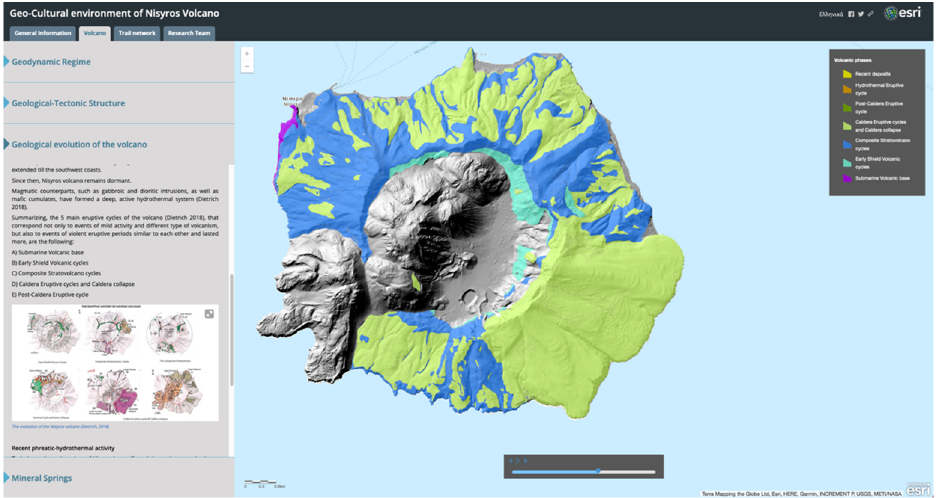
Figure 13. Screenshot showing part of the narration about the geological evolution of the volcano accompanied by a 2D webmap featuring the spatial distribution of the different eruptive phases that led to the island’s present-day morphological shape. Users can activate the player, or they can manually advance time for the different volcanic formations to appear on the map.